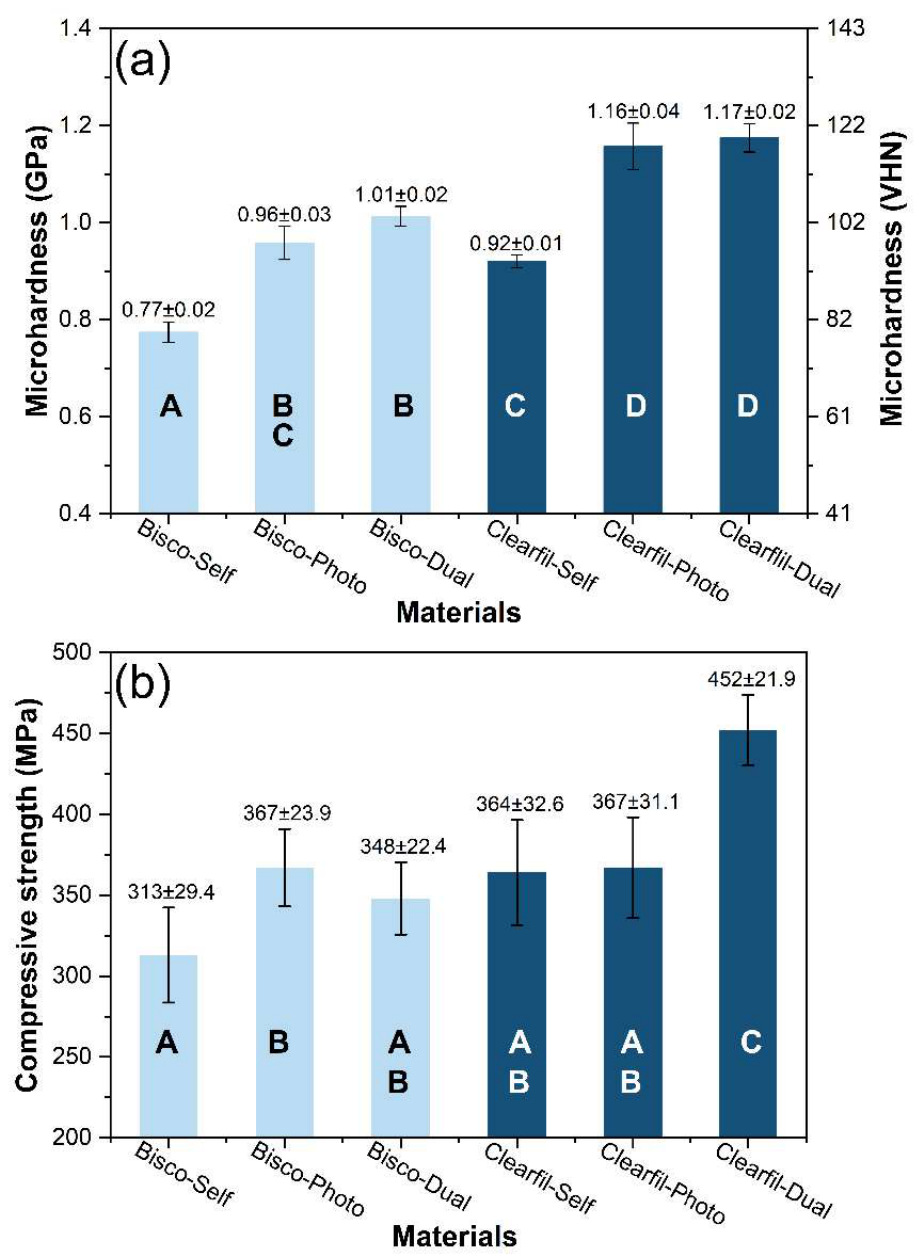
Figure 2. Mean and standard deviation values of ( a ) microhardness and ( b ) compressive strength of core composites. The same letters indicate no significant difference between materials ( p > 0.05).